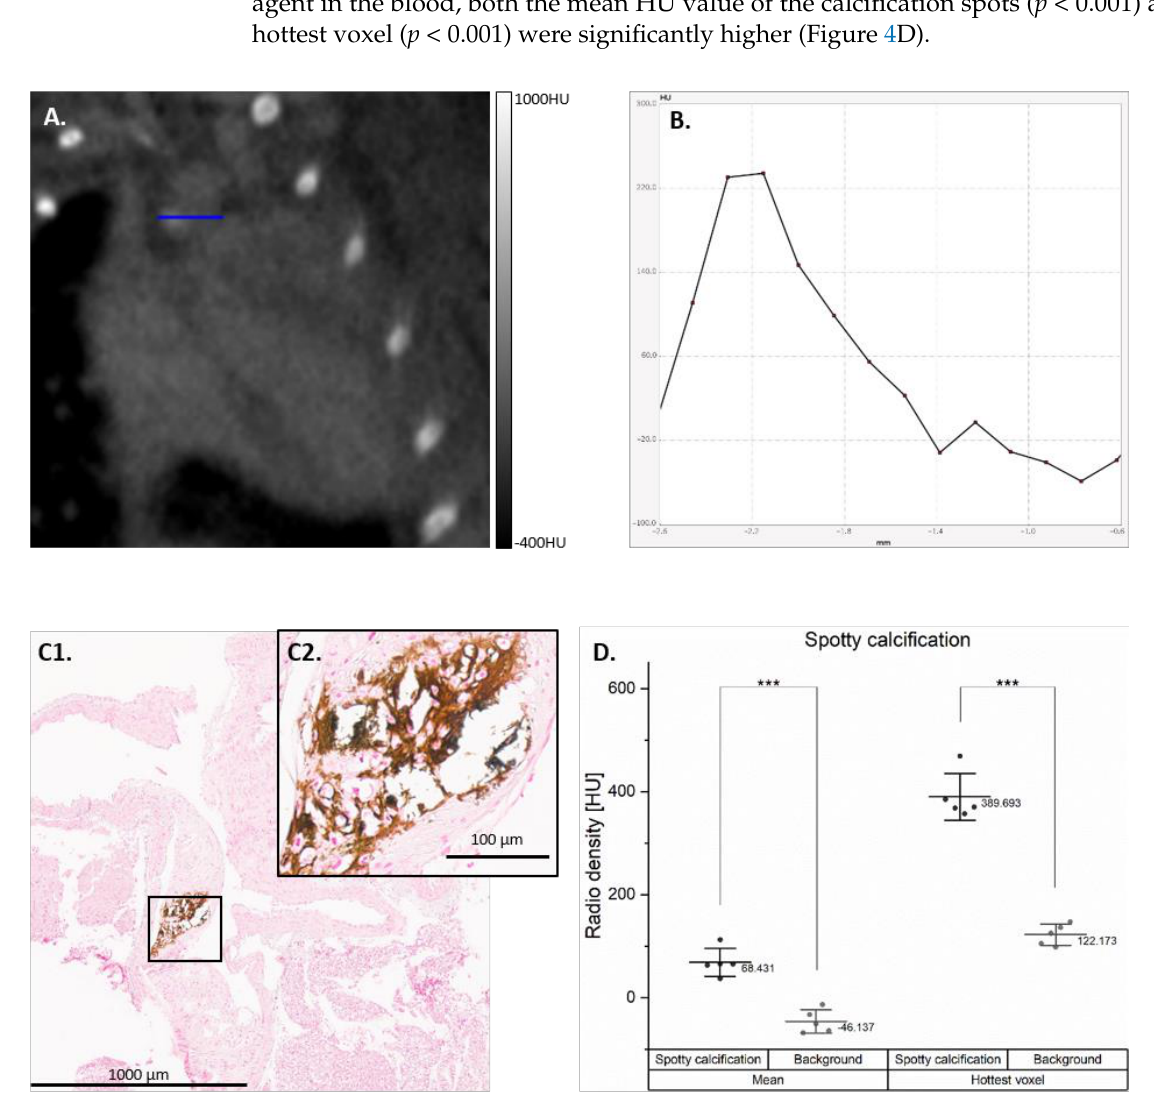
Figure 4. Spotty calcifications developed by the Warfarin group. Example of spotty calcification developed on the CT from the Warfarin group ( A ) with horizontal line profile ( B ). The spotty calcification was correlated with intense mineralization in the aortic arch in the von Koss staining ( C1 ), with a ×40 enlargement ( C2 ). The mean Hounsfield units (HU) value (averaged) and the hottest voxel (max) of the spotty calcifications are compared to the blood pool background created by the contrast agent ( D ); *** p < 0.001).